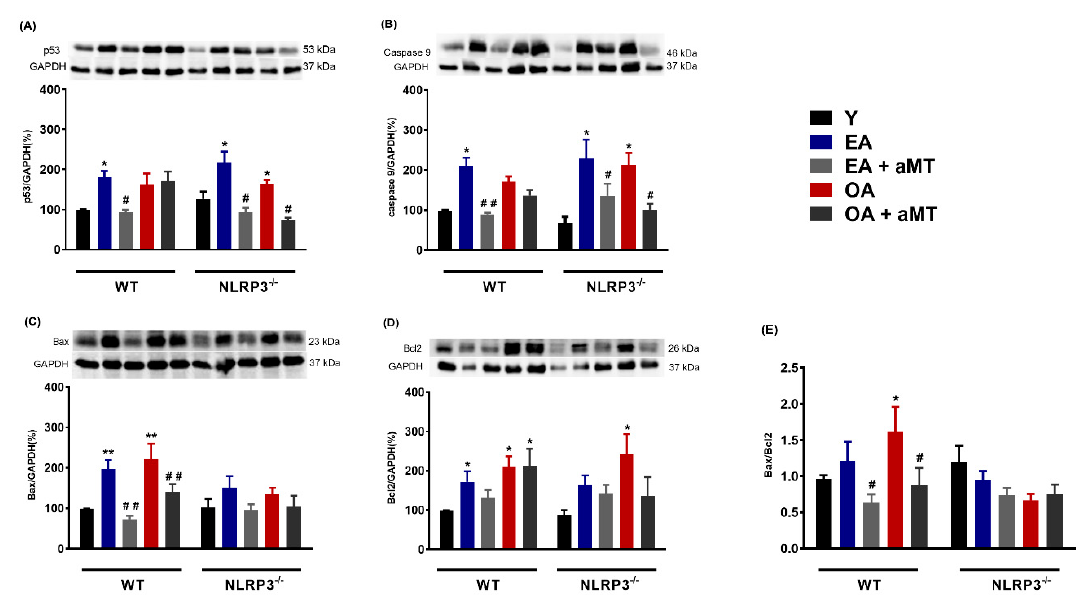
Figure 4. Changes in apoptosis in WT and NLRP3 − / − mice during aging and melatonin treatment. ( A ) Protein levels of p53. ( B ) Protein levels of caspase 9. ( C ) Protein levels of Bax. ( D ) Protein levels of Bcl2. ( E ) Bax / Bcl2 ratio. Experiments were performed in hearts of young (Y), early-aged (EA), early-aged with melatonin (EA + aMT), old-aged (OA), and old-aged with melatonin (OA + aMT) wild type and NLRP3 − / − mice. Data are expressed as means ± SEM ( n = 7 animals / group). * p < 0.05, ** p < 0.01 vs. Y; # p < 0.05, ## p < 0.01 vs. group without melatonin treatment.